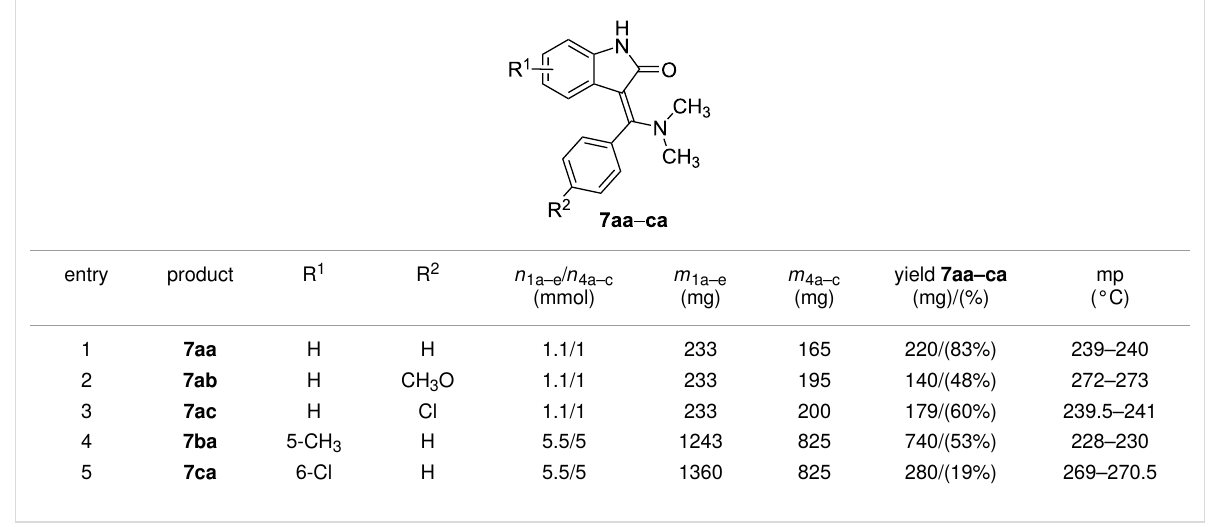
Table 4: The prepared ( Z )-3-[dimethylamino(phenyl)methylidene]-1,3-dihydro-2 H -indol-2-ones 7aa–ca with a tertiary amino group (R 3 and R 4 : CH 3